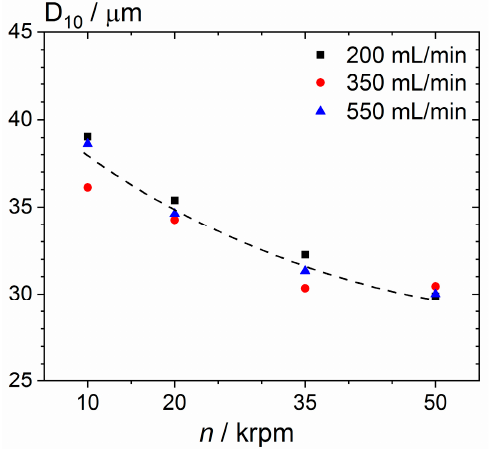
Figure 8. Arithmetic mean droplet diameter D 10 of the waterborne basecoat as a function of rotational speed n for different volumetric flow rates (cid:1848)(cid:4662) .